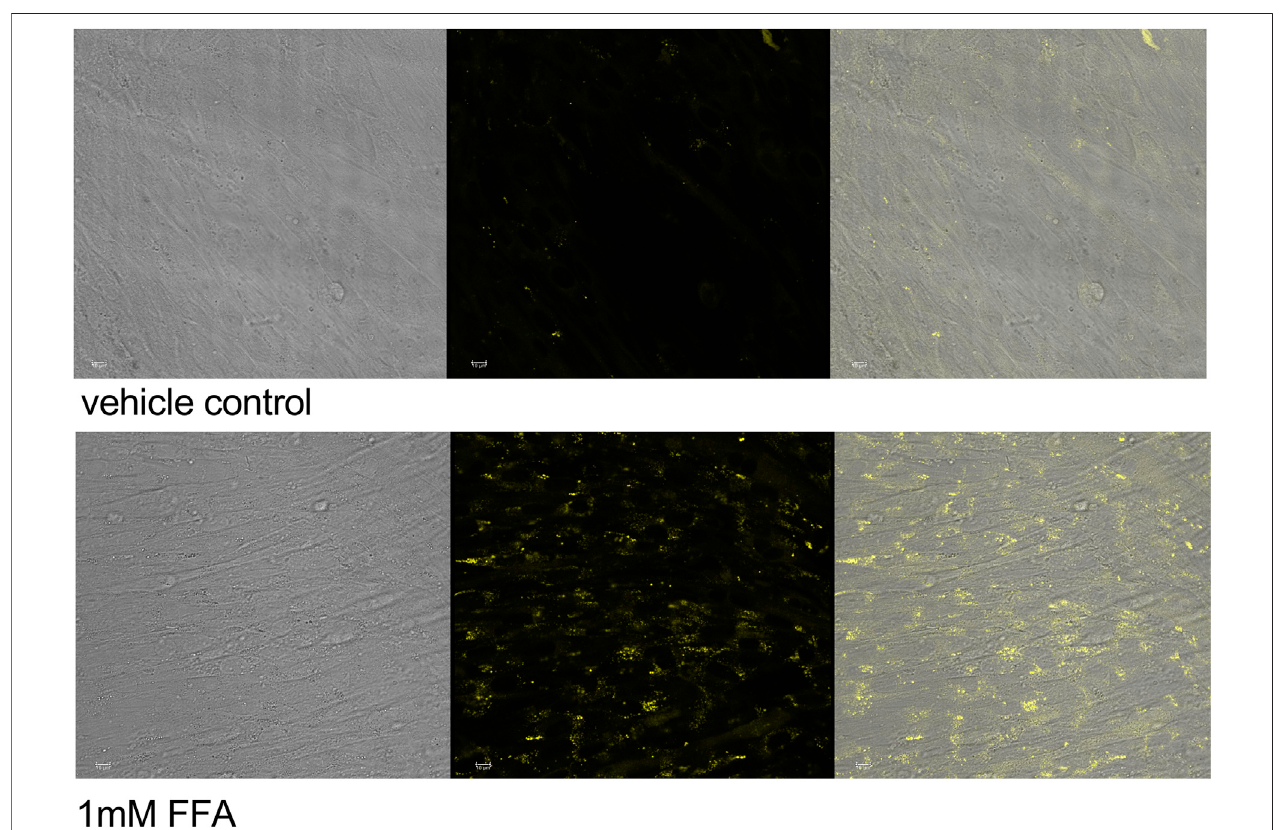
FIGURE3| Lipidaccumulationand lipid dropletformationin C2C12 myotubes Cellswereincubated for5 h, stained withNRand viewedby fl uorescence confocal microscopy. Transmission (left) , fl uorescence (center) images and overlay (right) , ex: 488 nm, em: 509 – 560 nm, no adjustment of gain.